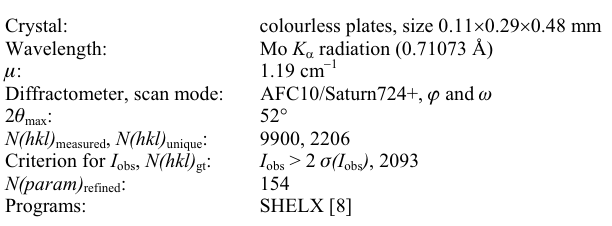
Table 1. Data collection and handling.